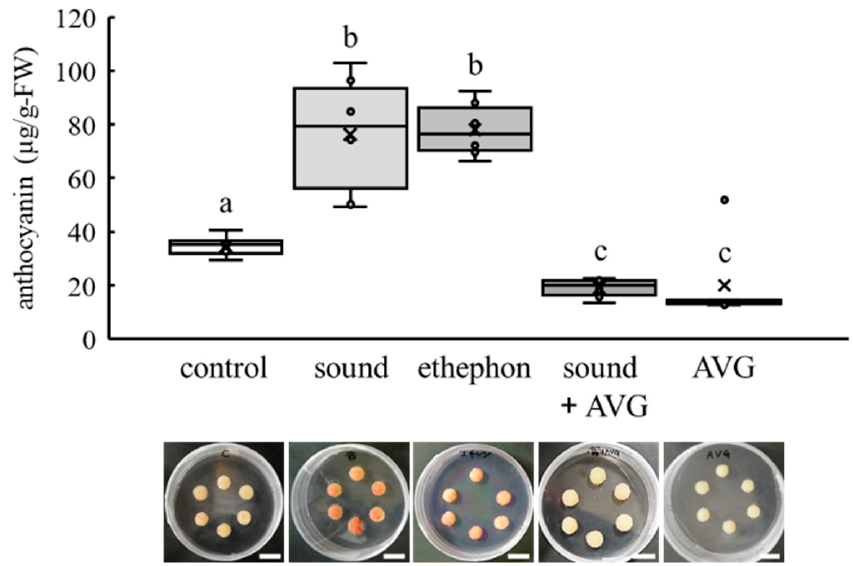
Figure 4. Effect of ethephon and AVG on anthocyanin accumulation in VR cells exposed to sound stimulation. VR cells were treated with ethephon, an ethylene-releasing compound. Another group of VR cells exposed to sound stimulation were treated with AVG, an inhibitor of ethylene biosynthesis. Anthocyanin content was measured 21 d after treatment. Data indicate means ± standard errors. Crosses ( × ) indicate means of two independent experiments with six VR cell masses. Different letters (a,b,c) above the boxes indicate statistically significant differences ( p < 0.01, Tukey). Representative VR cells are shown below the graph. Scale bar: 1 cm. Control: no treatment. Sound: sound stimulation at 1000 Hz. Ethephon: 1 µ M ethephon treatment. Sound+AVG: sound stimulation at 1000 Hz and 1 µ M AVG treatment. AVG: 0.1 µ M AVG treatment.